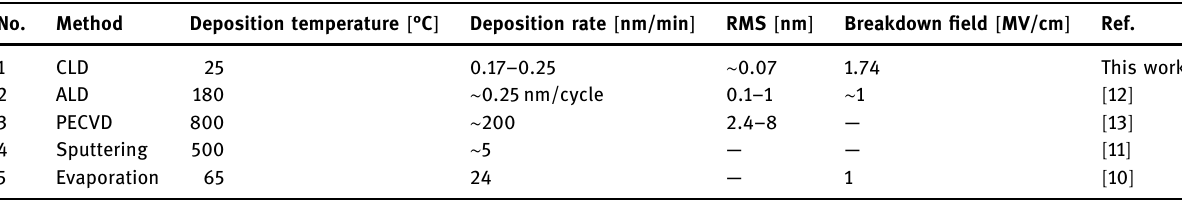
Table 1: Comparison of di ff erent traditional Al 2 O 3 deposition methods with CLD No.